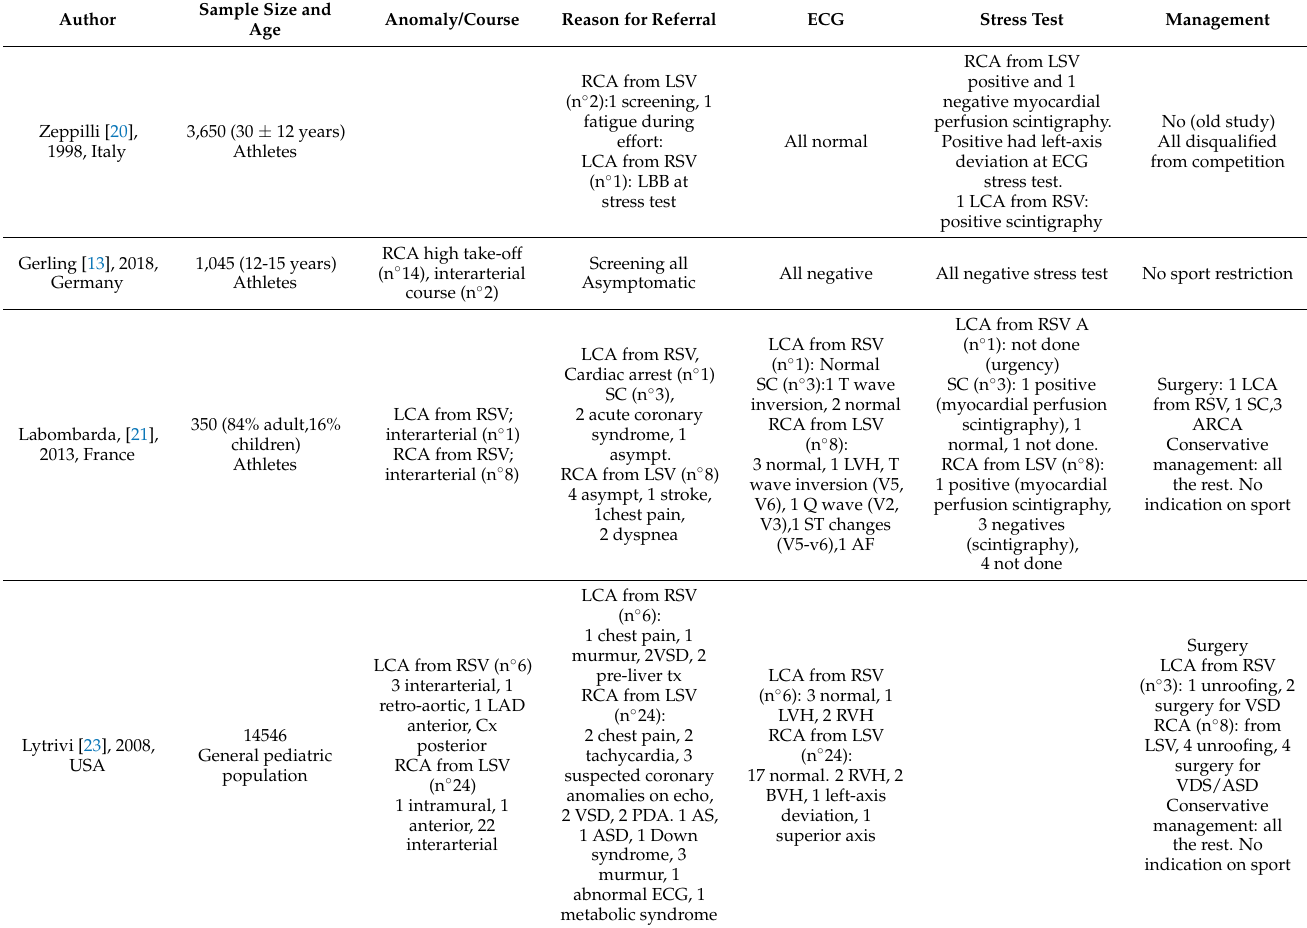
Table A1. Studies reporting information about the reason of echocardiographic examination, ECG, stress test results and